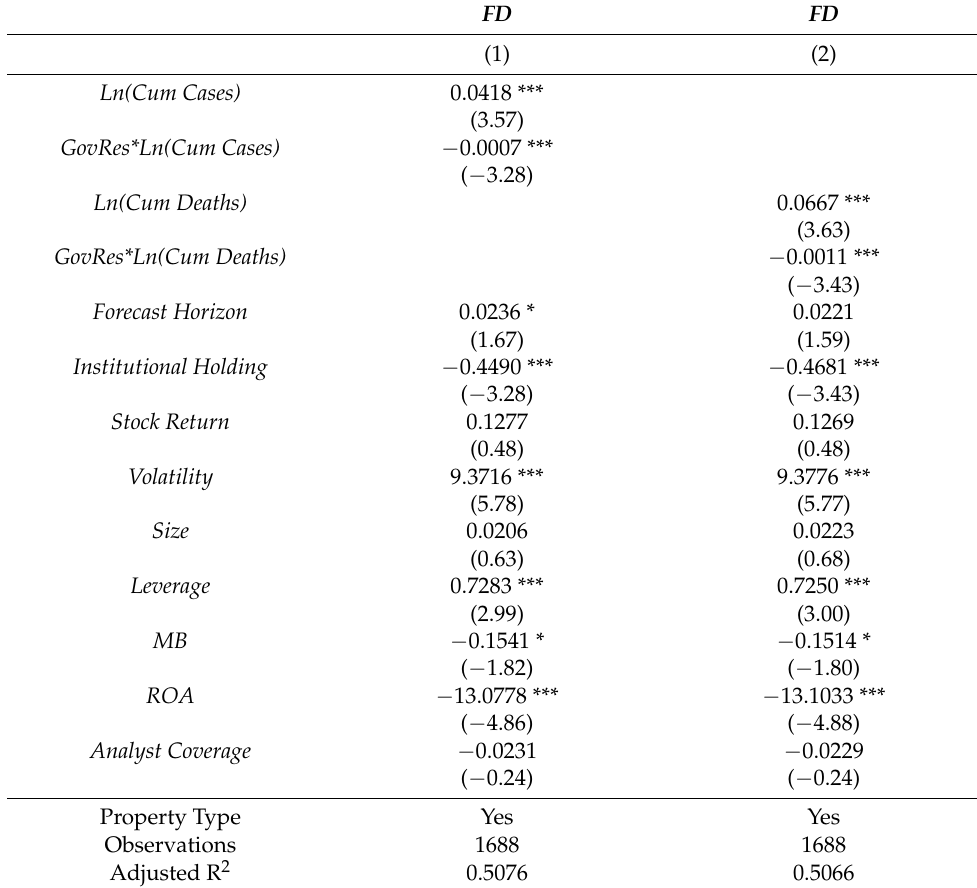
Table 4. The COVID-19 Pandemic and Forecast